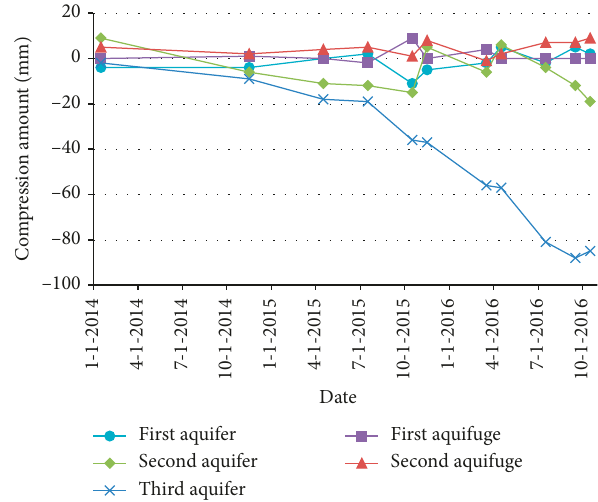
Figure 9: Compression process of alluvial strata near the west ventilation shaft in the Xinglongzhuang Coal Mine.